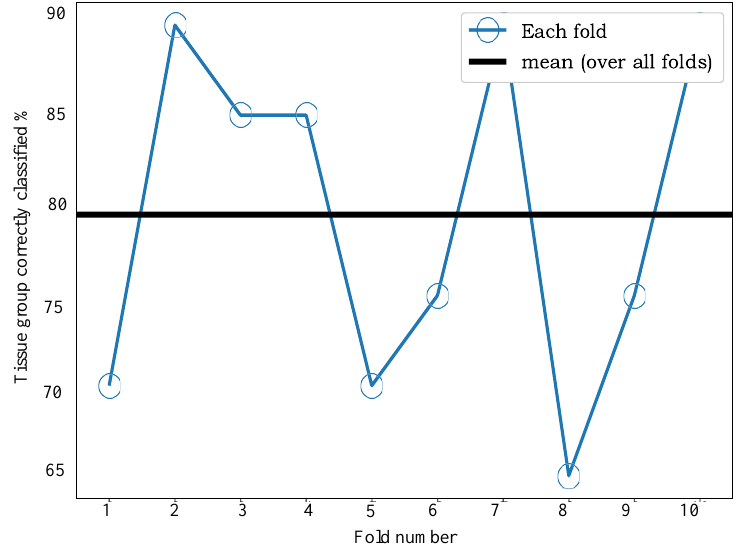
Figure 7. Endometrial cancer 10-fold cross-validation accuracy for per-tissue-group classification. The mean classification accuracy over the 10 folds is 79.5%. The lines joining markers are a guide to the eye.